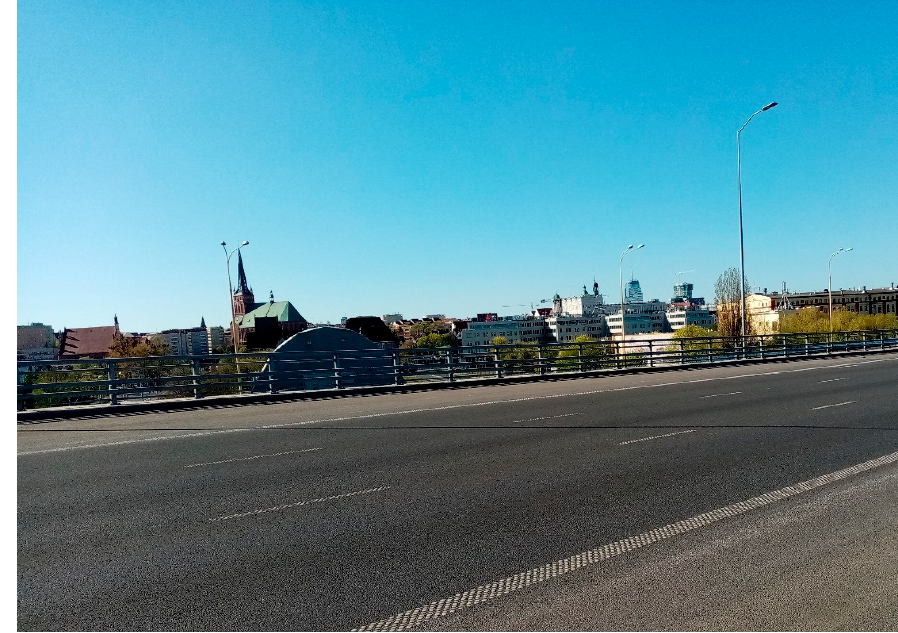
Figure 19. Bridge pavement with the protective layer made of SMA-MA 8 mixture two years after renewal.